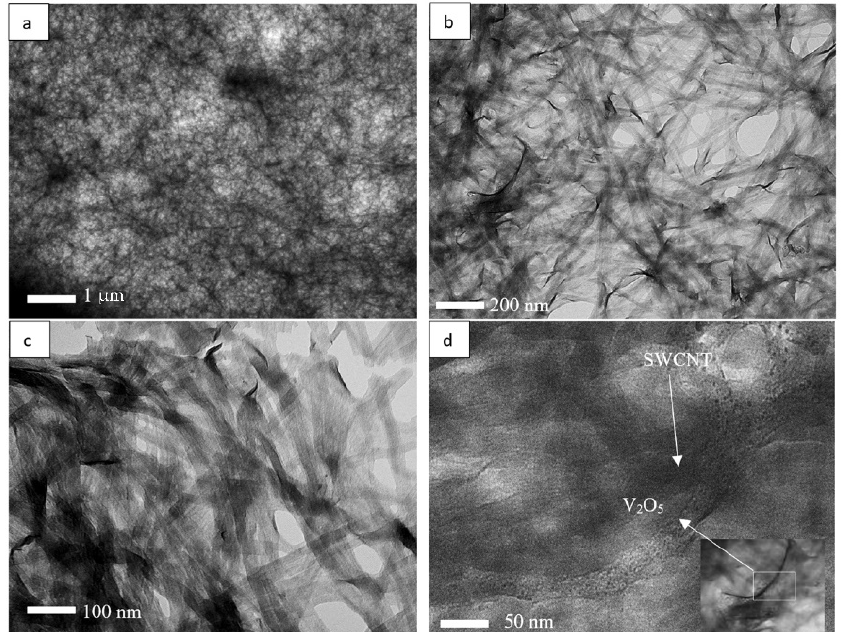
Figure 5. TEM images of the V 2 O 5 -SWCNT hybrid structure. ( a ) Low magnification TEM images show a network of V 2 O 5 -SWCNT. ( b ) Higher magnification reveals nanostructures that show parallel strands of SWCNT and V 2 O 5 layers. ( c , d ) Confirmation that V 2 O 5 nanoribbons are sandwiched between SWCNTs with a repeated structure.